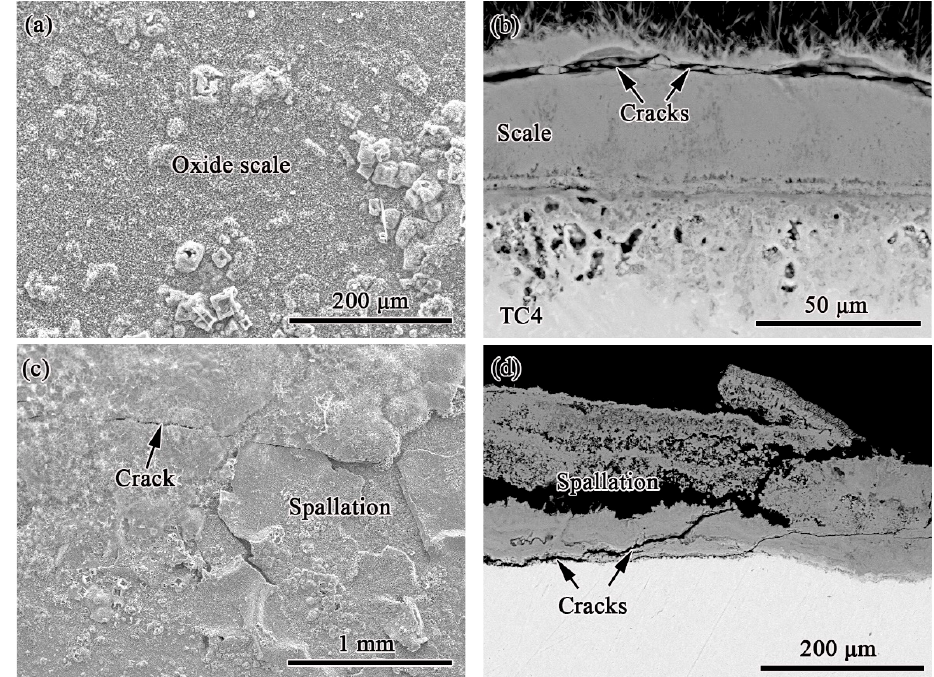
Figure 5. Surface ( a , c ) and cross-sectional ( b , d ) morphologies of uncoated alloy after corrosion in marine environment for 100 h at 650 °C.